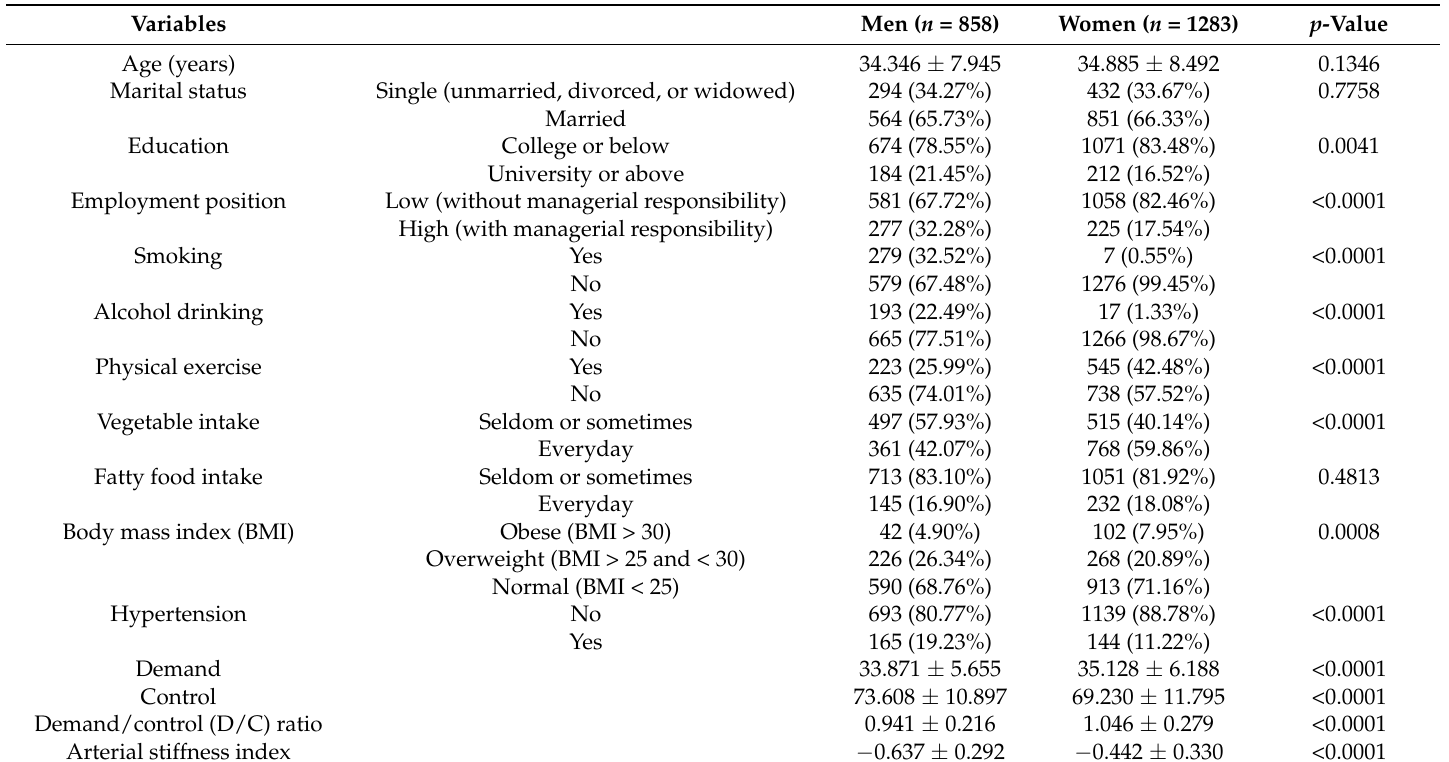
Table 1. Characteristics of study subjects ( n =